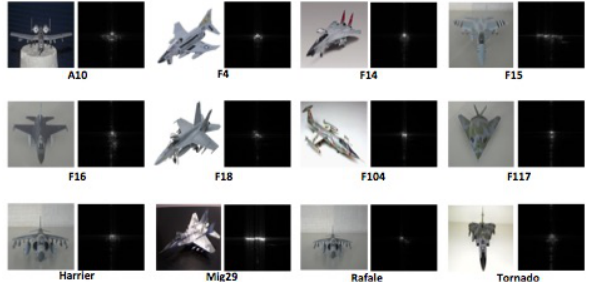
Figure 4. Twelve classes of ISAR